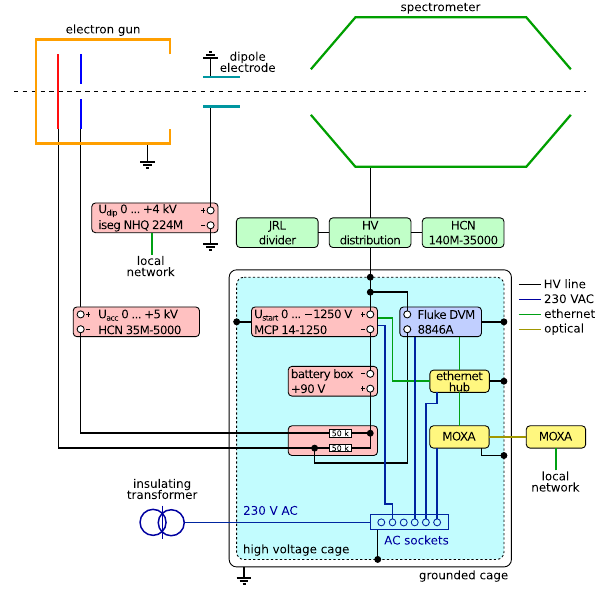
Fig. 5 High voltage scheme of the test setup. The base voltage pro- vided to the spectrometer defines the retarding potential (HCN 140M- 35000). The high voltage system of the electron source is placed inside a HV cabinet. The source voltage can be varied by means of a variable power supply (FuG MCP 14-1250) and a constant voltage source (bat- tery). The resulting potential difference between electron source and spectrometer is monitored by a DVM (Fluke 8846A). The acceleration voltage is provided by an additional power supply (FuG HCN 35M- 5000), which operates on top of the source voltage. The devices are controlled by a network interface; the connection into the HV cabinet is provided by a MOXA system with optical connections. The dipole electrode power supply (iseq NHQ 224M) is controlled independently